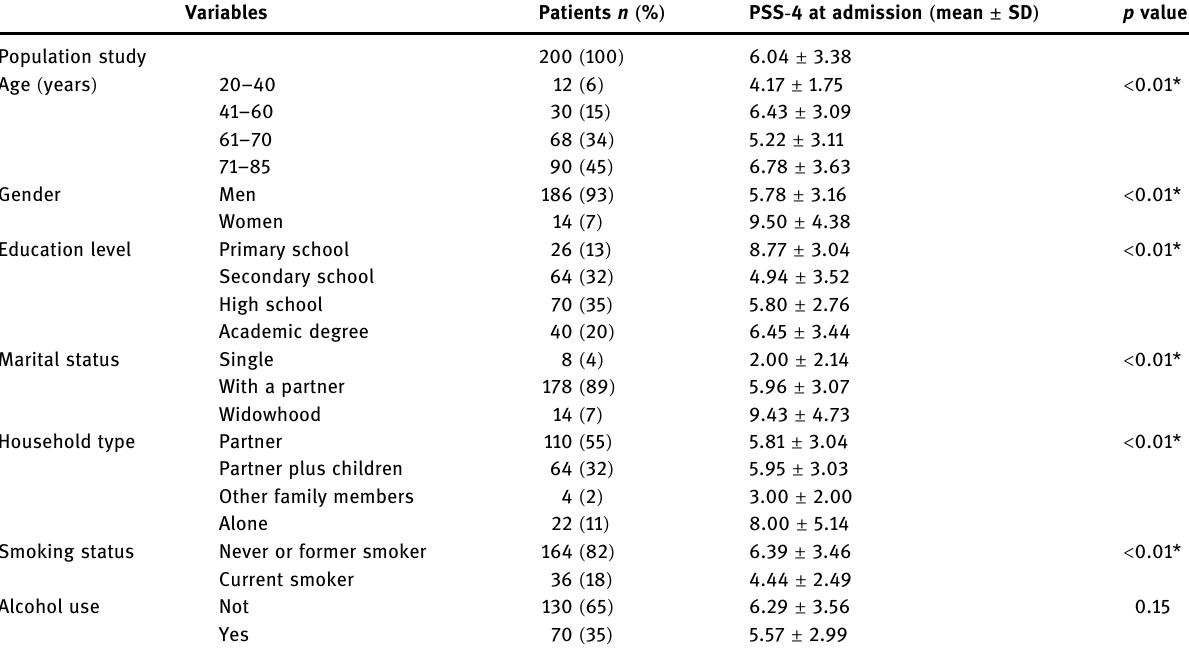
Table 1: Demographic data and univariate analysis of mean values of PSS - 4 at hospital